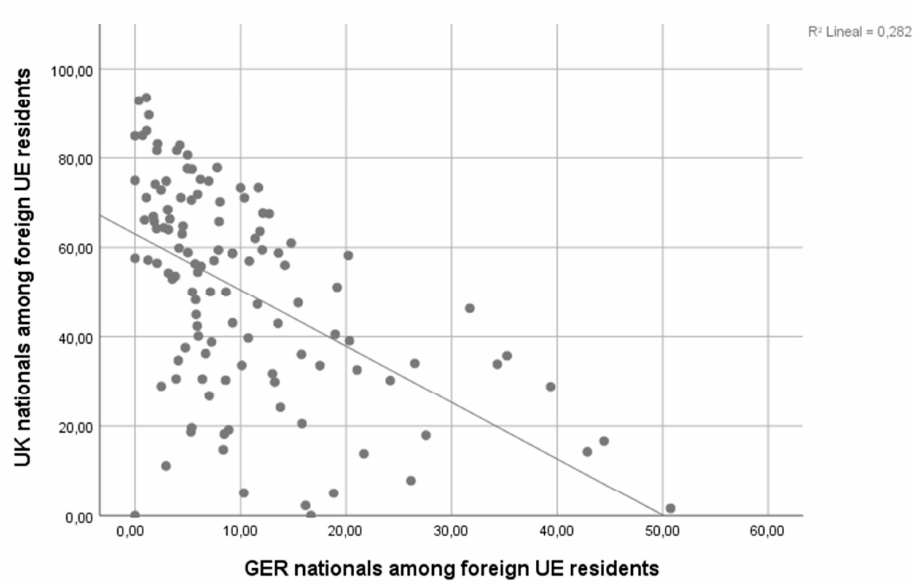
Figure 2. Spatial concentration by nationality. Each dot is a municipality. In the horizontal axis one can see the share of German nationals among all foreign residents of 65 years old and more. In the vertical axis one can see the share of UK nationals among all foreign residents of 65 years old and more. The line is the regression line for a linear regression model with the two variables. Source: Own elaboration with Local Register data.